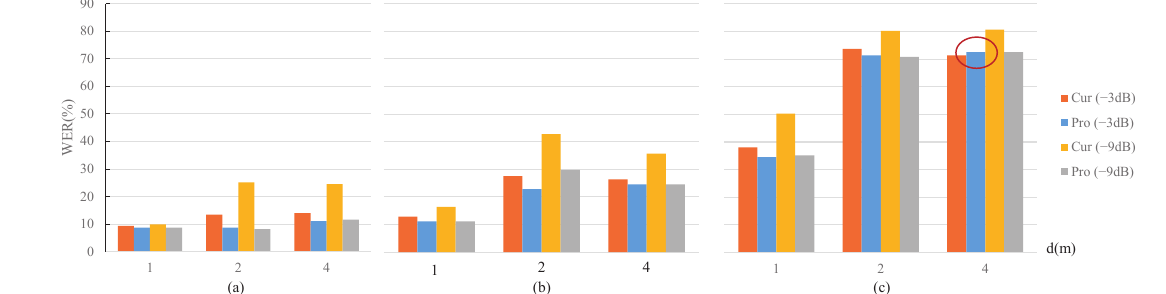
Figure 9. WER comparisons under different RT60 and speaker-microphone distance conditions. ( a ) RT60 = 0.5 s. ( b ) RT60 = 0.7 s. ( c ) RT60 = 1